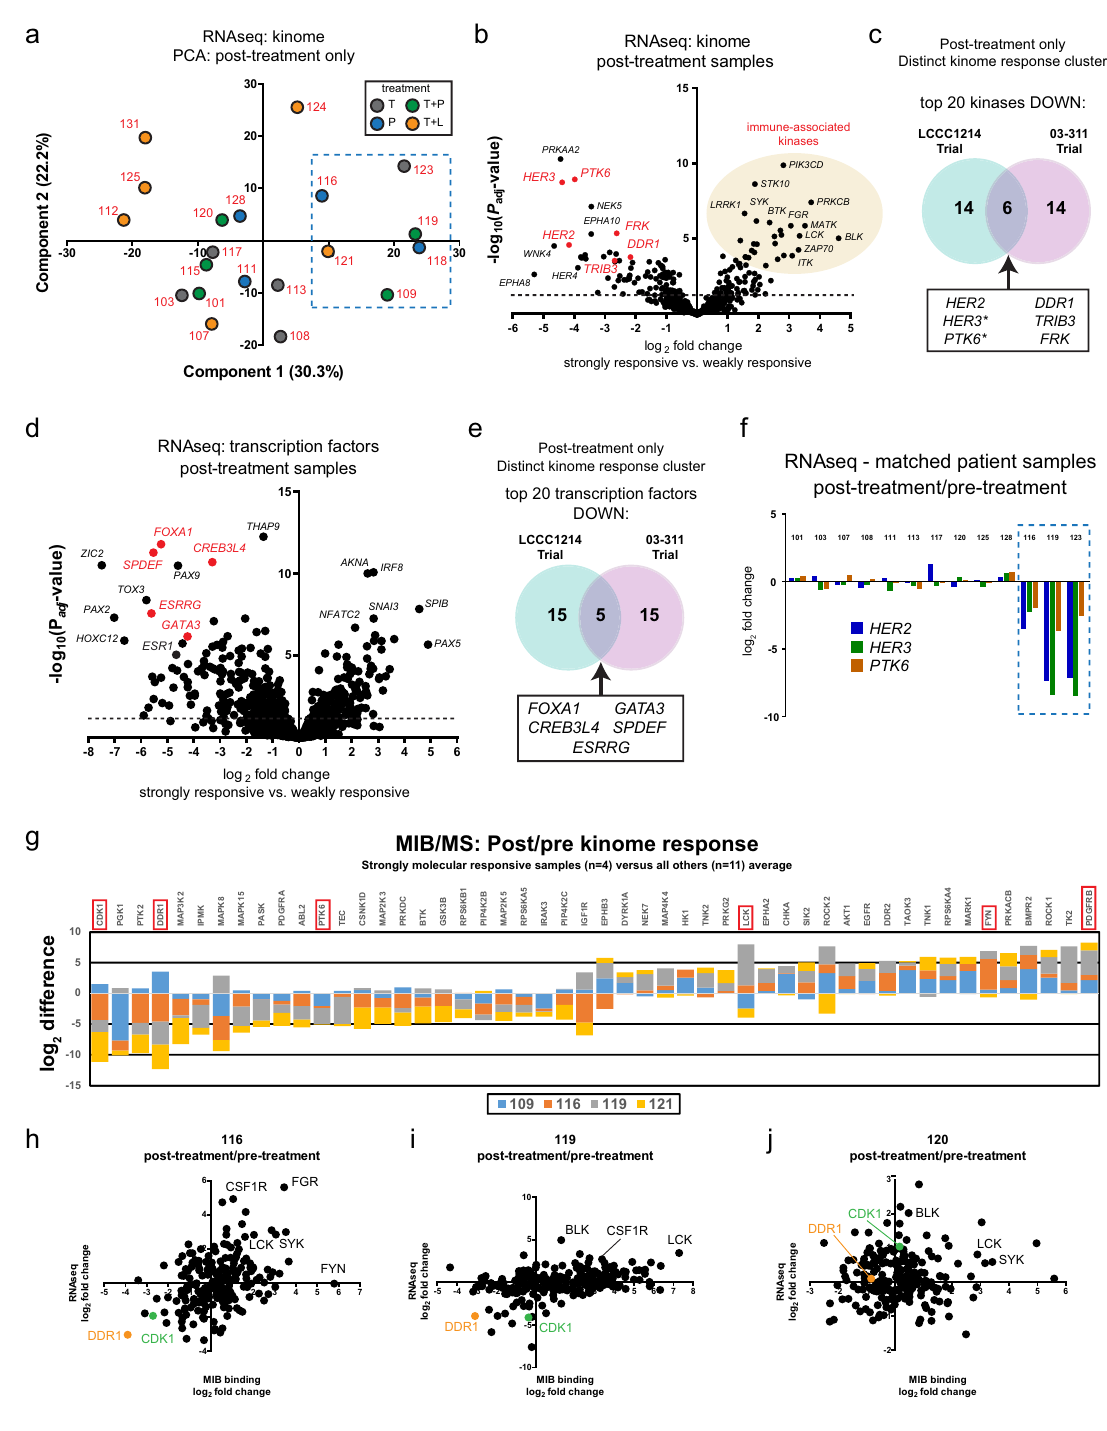
hierarchical clustering of the kinome expression data from this study identi fi ed a subgroup of 7 out of 50 total tumor specimens